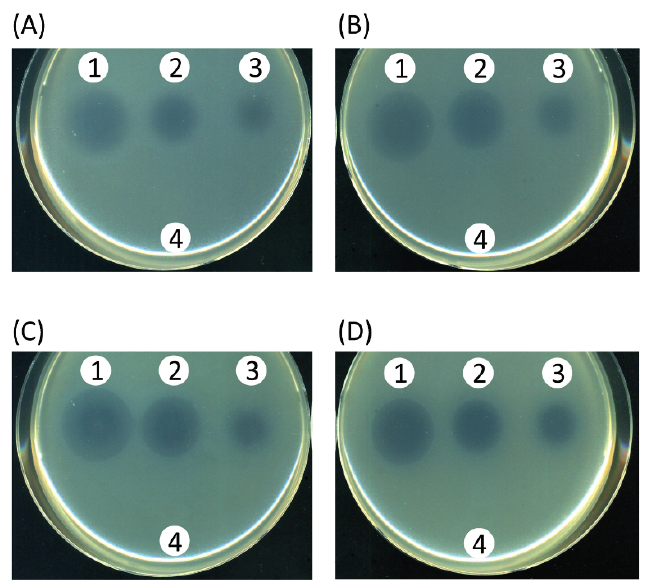
Figure 5. Effect of YH001 on the growth of P. aeruginosa producing different levels of the efflux pump in the presence of antibiotics. ( A , B ), a wild type strain PAO4290 producing a basal level of MexAB-OprM pump. ( C , D ), a strain producing an elevated level of MexAB-OprM pump, TNP30#1. Agar plates were prepared as described in the legend to Figure 4 impregnated with the following: (A) dipyridyl (0.5 mM) and aztreonam (2.0 µg/mL), (B) aztreonam (2.0 µg/mL), (C) dipyridyl (0.5 mM) and aztreonam (8.0 µg/mL), and (D) aztreonam (8.0 µg/mL). Concentrations of YH001 used were; 1, 10 mM; 2, 5 mM;